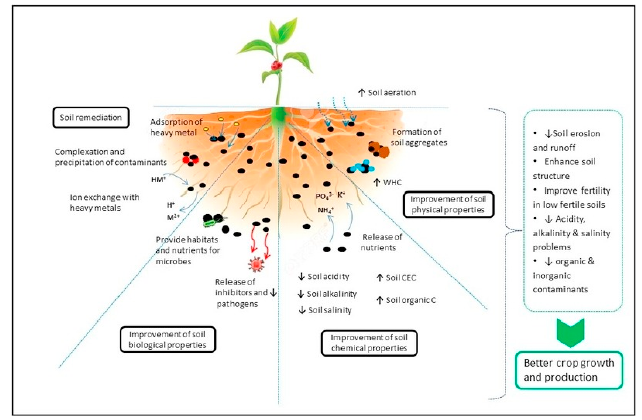
Figure 4. Influence of biochar on soil properties [131].